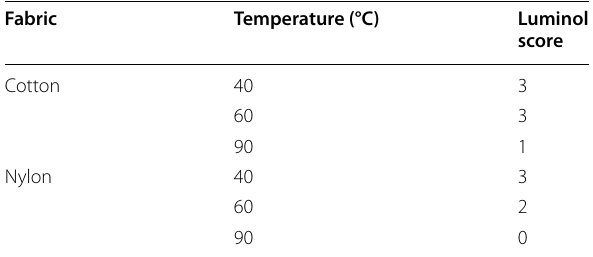
Table 3 Washing temperature and corresponding luminol score for both fabric types